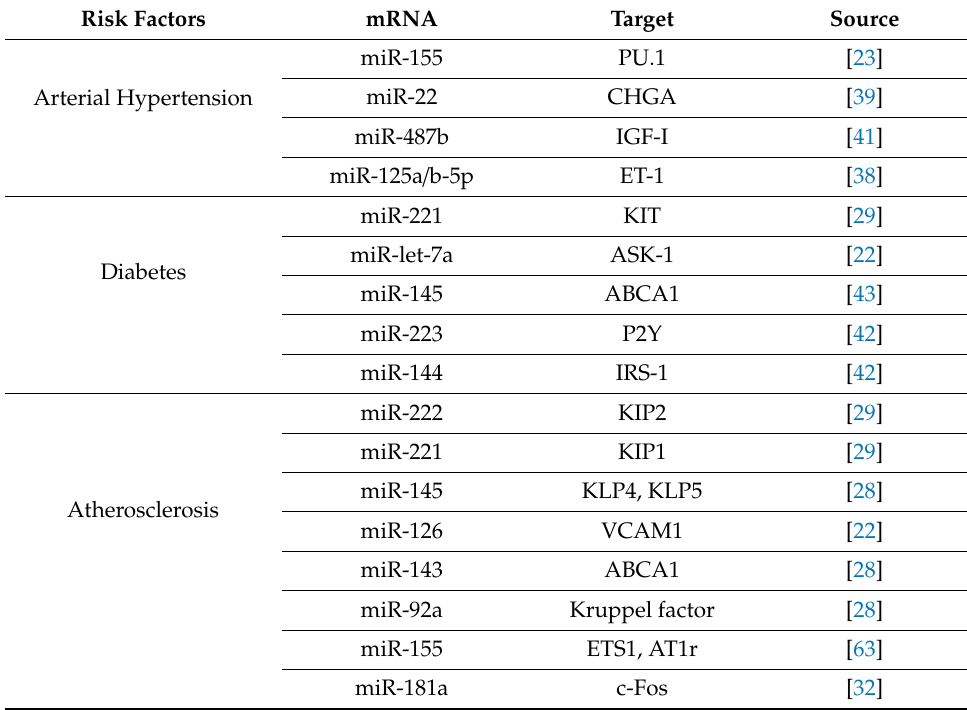
Table 3. The significant role of miRNAs in targeting several mRNAs to modulate the production of target proteins involved in the etiology of ischemic